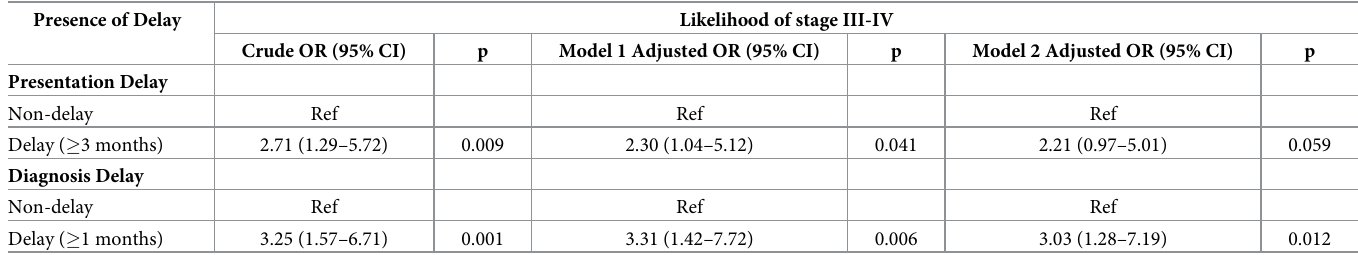
Table 5. Effect of presentation and diagnosis delay on likelihood of stage III-IV breast cancer at point of diagnosis. Presence of Delay